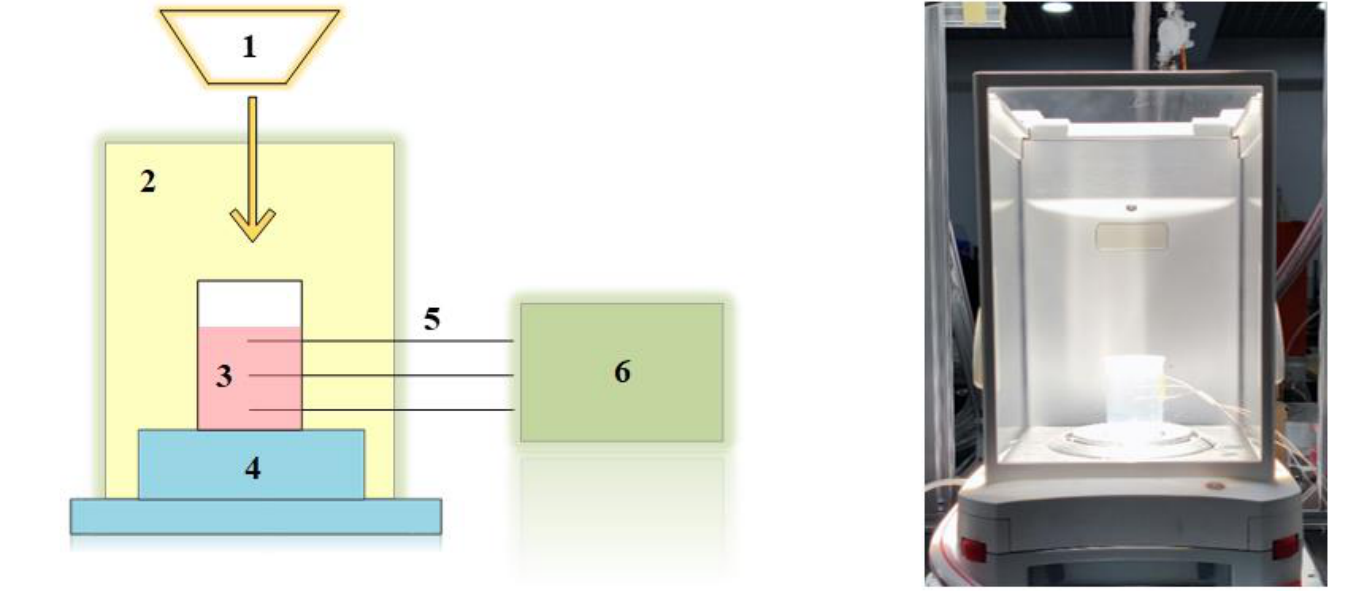
Figure 4. Experimental setup for solar – thermal conversion characteristics of nanoparticles. 1. Solar simulator. 2. Windshield. 3. Test container filled with nanofluids. 4. Digital mass balance. 5. Thermocouple. 6. Data acquisition system.